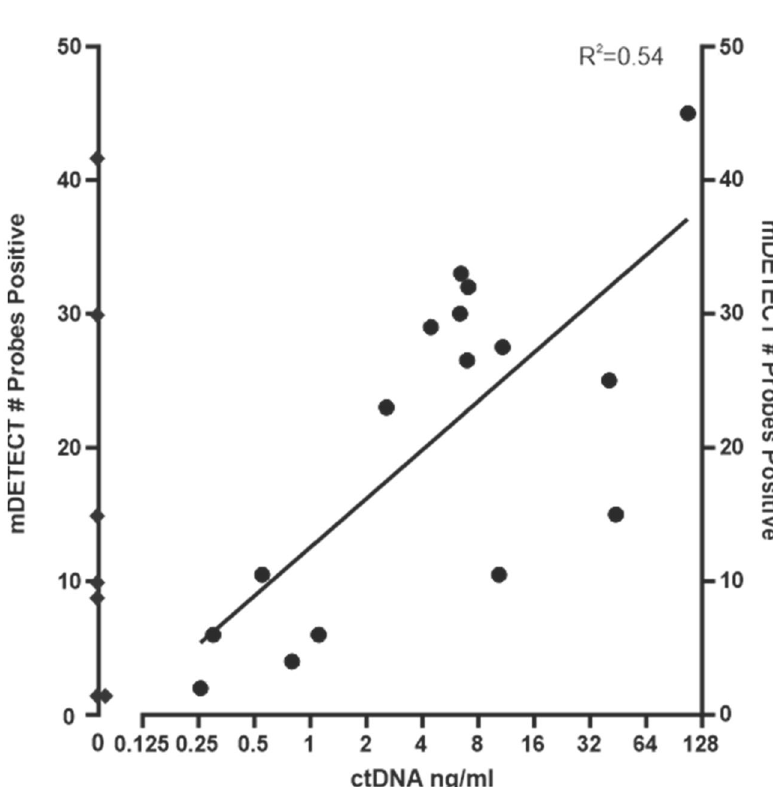
Fig. 8 mDETECT versus ctDNA levels determined by TP53 mutation sequencing. A next-generation sequencing TP53 mutation-based test was previously used to quantitate ctDNA levels in the plasma from these patients and is expressed on a log scale as ng of ctDNA per ml of plasma ( x -axis). The number of mDETECT probes that were positive for methylation for each sample is plotted (right y - axis). For samples that were negative for the TP53 assay (Diamonds) the mDETECT levels are plotted on the left y -axis as zero cannot be plotted on a log scale. Regression analysis shows that the relationship between mDETECT and TP53-based levels is reasonably well correlated ( R 2 =